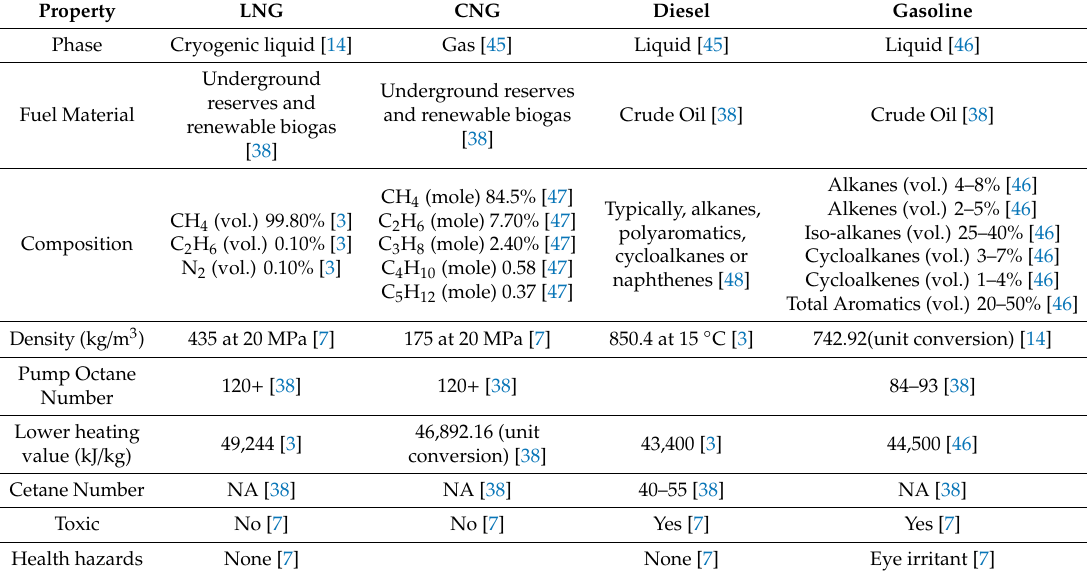
Table 3. Comparison of di ff erent properties of LNG with CNG, diesel and